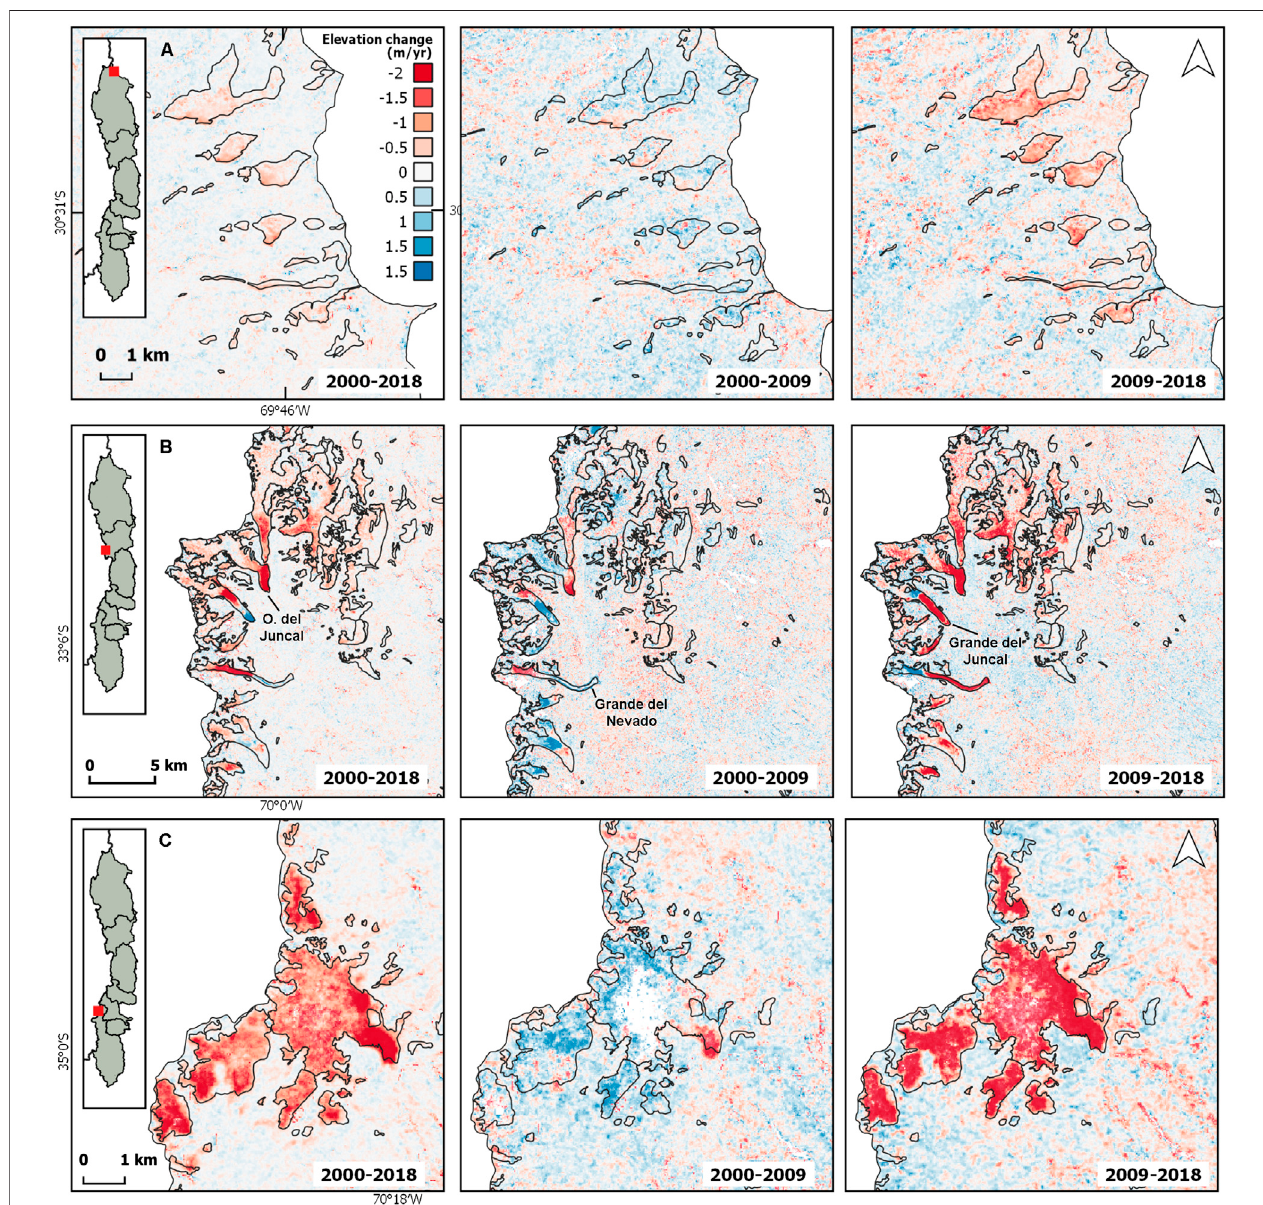
FIGURE 6 | Examples of elevation changes in different areas of the Central Andes for different sub-periods. NGI glacier outlines are shown in black lines. (A) Small mountain glaciers and perennial snow fi elds in San Juan basin. (B) Large valley glaciers in Mendoza basin, some of them classify as surging glaciers. (C) Mountain and valley glaciers in Atuel